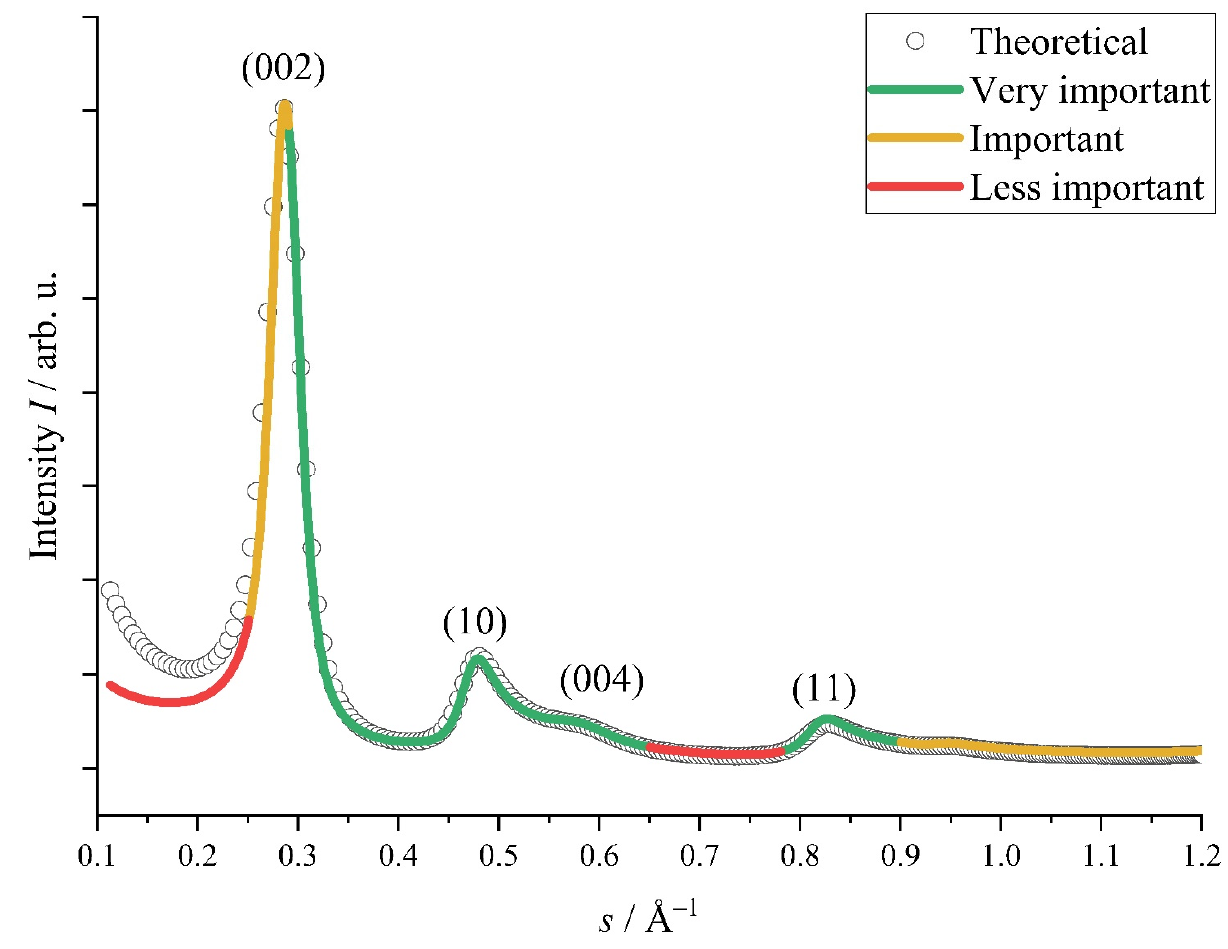
Figure 5. Theoretical WAXS data of NGCs and a typical, reasonable fit. Green: Most important regions for fitting, which are strongly influenced by the NGC microstructural parameters. These parts must be refined as well as possible. Based on our experience, the yellow regions are significantly influenced by foreign atoms, the measurement geometry and factors contributing to the incoherent scattering. Overall, the green regions should have a higher priority in judging the quality of a fitting result. While micropores influence the lower s -range of the red region, the range around s = 0.7 Å − 1 can be influenced by amorphous carbon with a bond length of around d C-C ~ 1.42 Å and s C-C = 1/ d c-c ~ 0.7 Å. As another point, only low amounts (< 5–10%) of unorganized carbon or foreign atoms such as nitrogen or oxygen can be considered well by the present model. Higher amounts can significantly influence the data at lower values of s , e.g., the red region. Our approach cannot model such higher concentrations of impurities, as it assumes that these atoms are isolated and show no mutual correlation in their position. Hence, a reasonable fitting of these specific regions might be impossible using OctCarb because these additive scattering contributions are not considered by our approach.